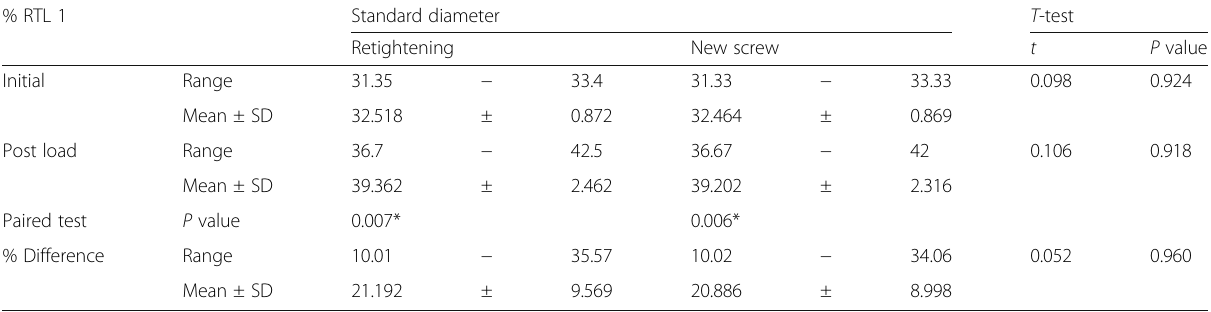
Table 3 Mean ± SD of percentage initial and percentage post load RTL 1 and percentage difference between initial and post load RTL 1 for GIA and GIB